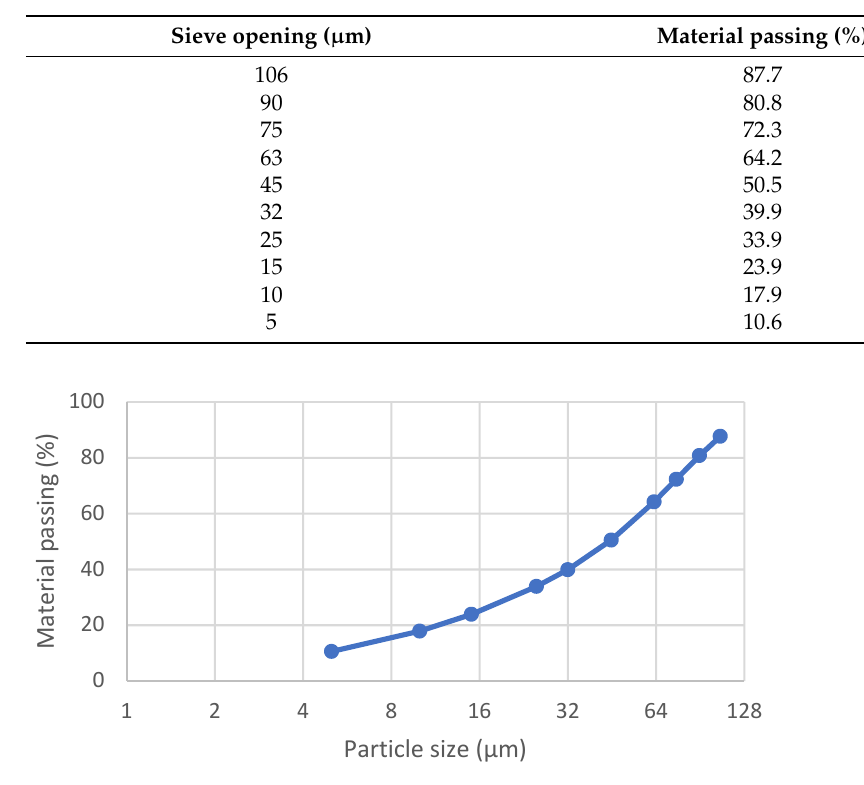
Figure 2. Particle size distribution for the ground flotation feed on a logarithmic scale.